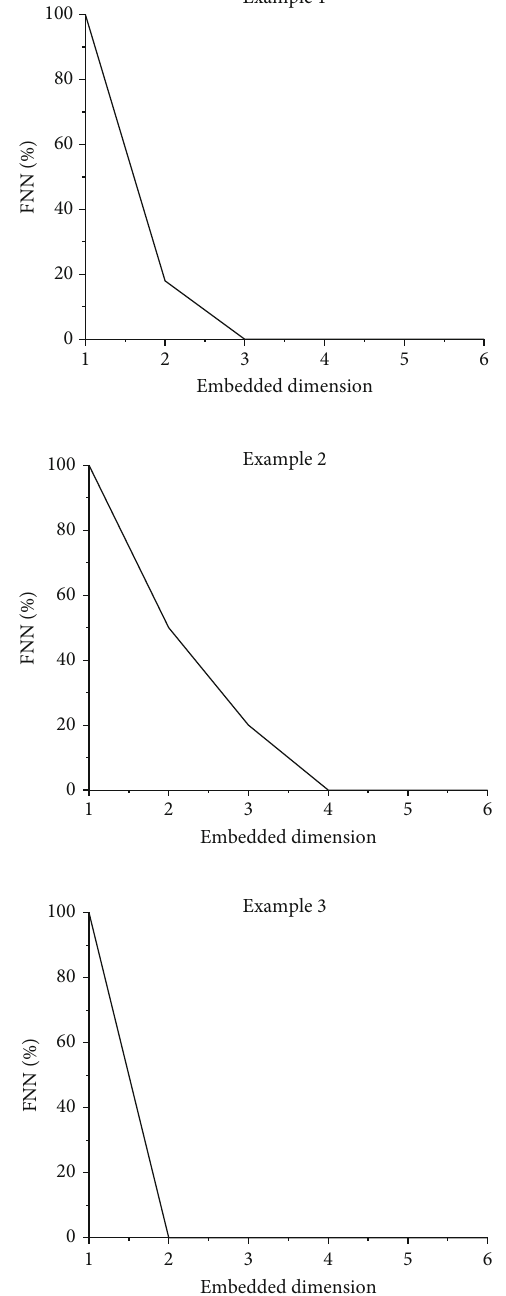
Figure 1: Results of false neighbor method for foundation pit monitoring